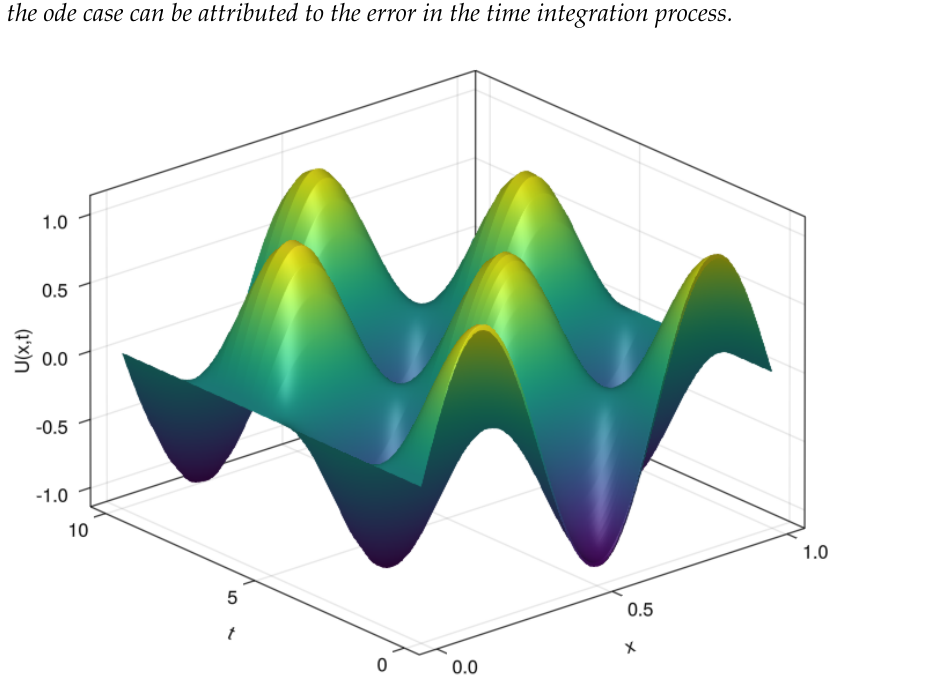
Figure 5. Approximate solution with N = 100 for Example 3.